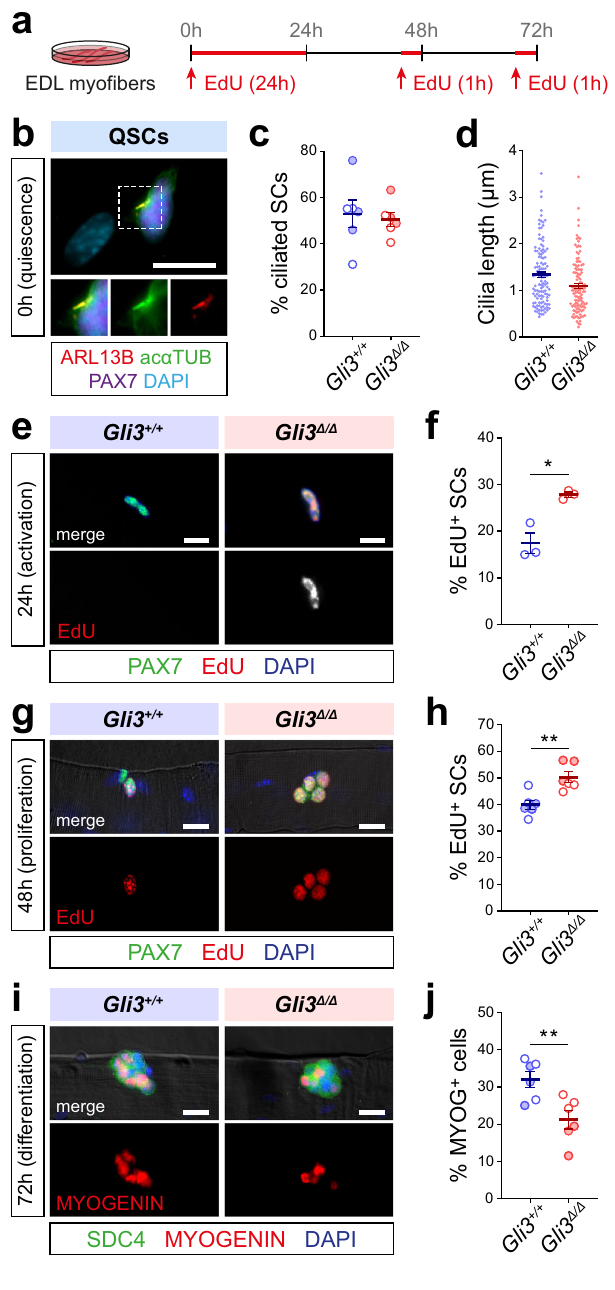
revealed two distinct groups based on the fi rst component axis (PC1), distinguishing the QSCs from the ASCs (Fig. 5b). PCA also revealed a high correlation between Gli3 + / + and Gli3 Δ / Δ